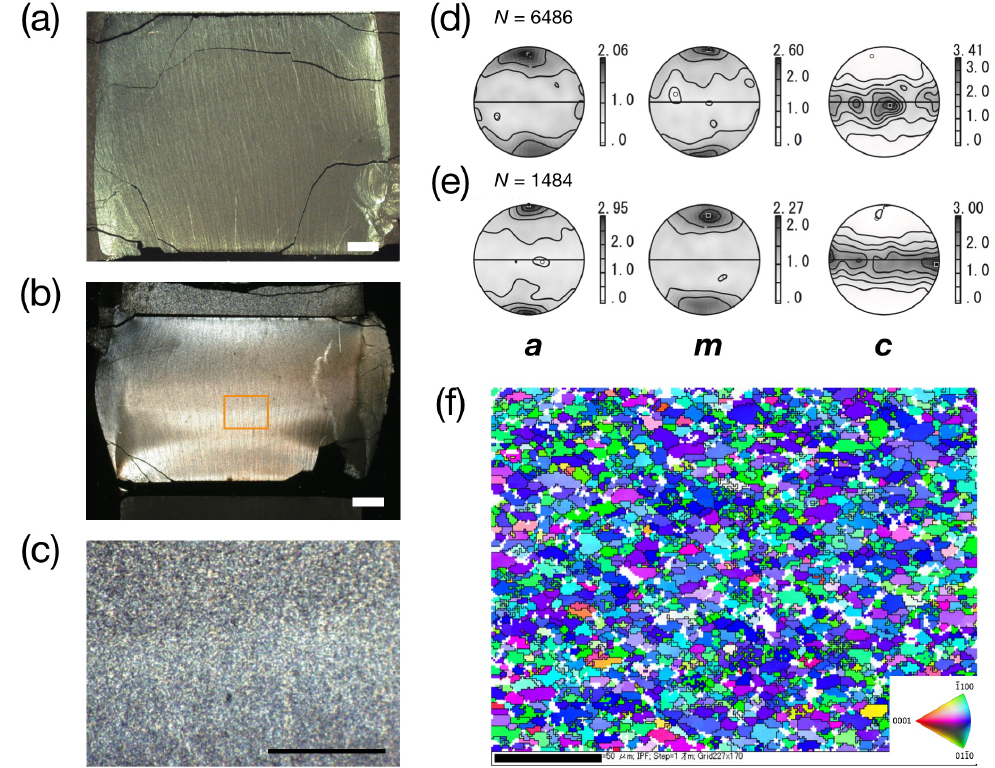
Figure 8. Microstructural observations of the samples after constant strain rate tests (W01, W02) conducted at 800 ◦ C and ˙ ε = 10 − 5 s − 1 . ( a , b ) show optical micrographs of thin sections after W01 and W02, respectively, under crossed polarized lights. Scale bars (white) are 2 mm. ( c ) Close up of the orange rectangular area of ( b ). The scale bar (black) is 1 mm. ( d , e ) show pole figures of a (cid:104) 11¯20 (cid:105) , m (10¯10), and c [0001] obtained in the samples of W01 and W02, respectively. The horizontal lines are parallel to the basal planes of the cylindrical samples. N is the total number of measurements. ( f ) An EBSD map of W02. The c -axes of red grains are oriented vertically, whereas those of blue to green grains are oriented horizontally. See the inverse pole figure for coloring of the crystal orientation with respect to the cylinder axis. Crystallographic orientations of blank pixels (white) were not indexed. The orientation data in the mapped area was used to construct the pole figures in ( e ). Scale bar is 50 µ m. The step size is 1 µ m. Compression direction is vertical for all